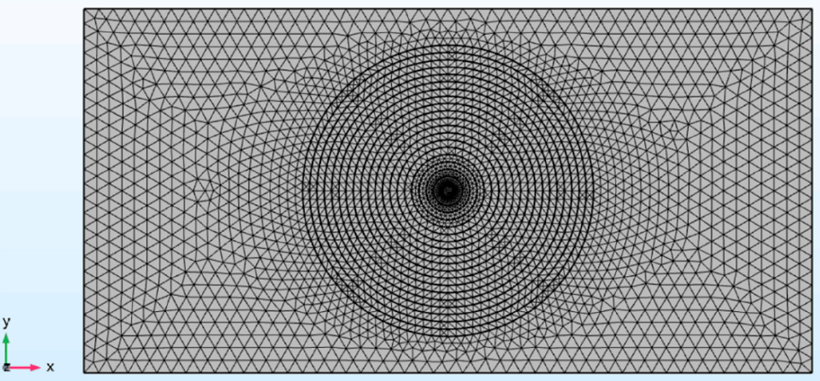
Figure 7. Finite element model for the 2D application.